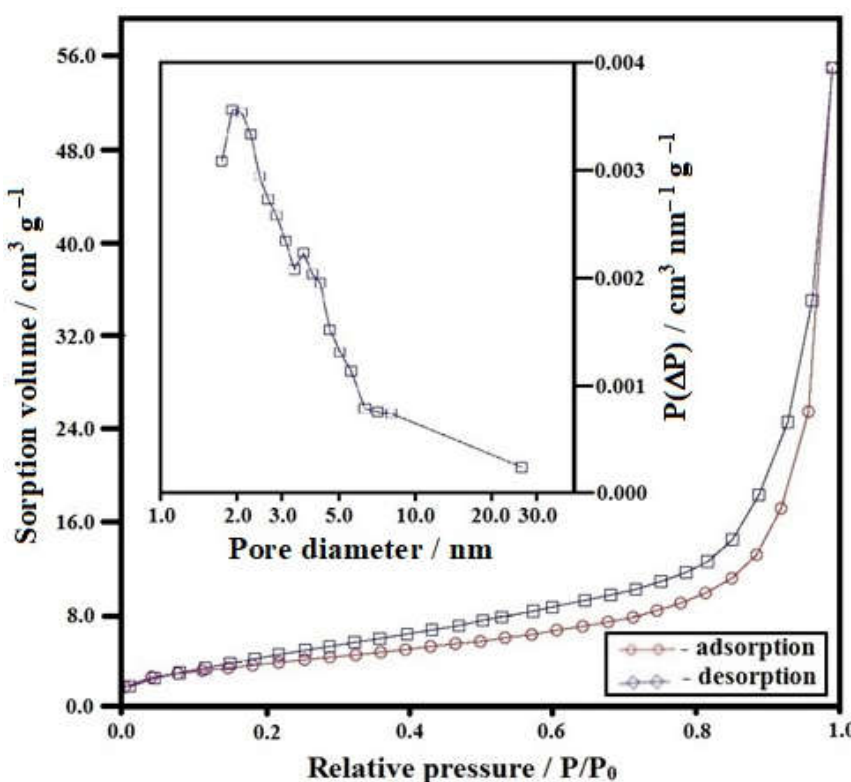
Figure 2. Adsorption–desorption isotherm and differential pore size distribution (caption) for